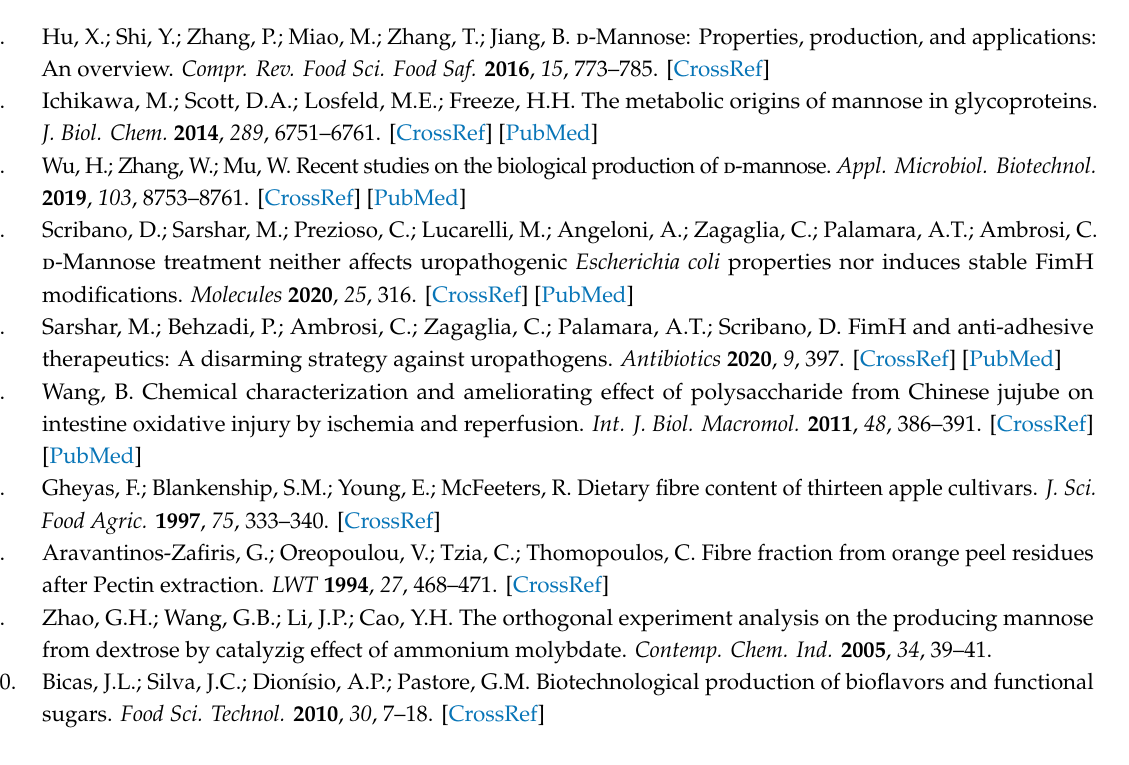
Figure S1: Active centers of AGE family epimerase / isomerase, Figure S2: High-performance liquid chromatography (HPLC) of d -fructose and d -mannose. The age gene encoding P. geniculata